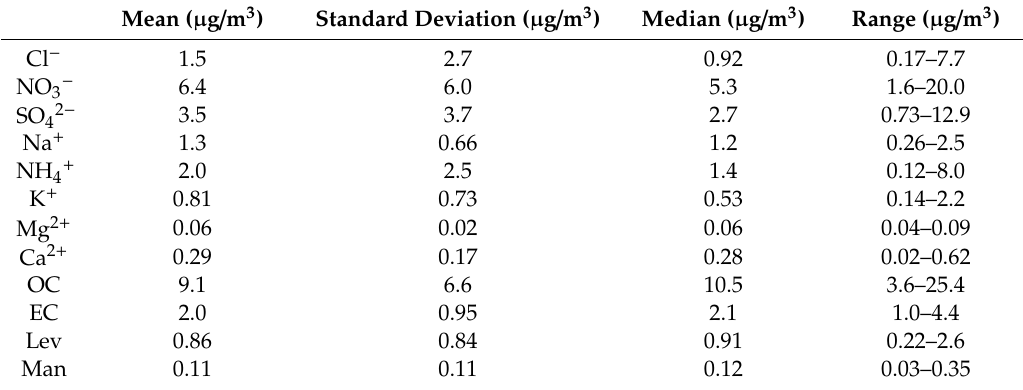
Table 2. Summary of ambient concentrations of major PM 2.5 constituents ( µ g / m 3 ) at the monitoring station located in Graz Don Bosco (DB), 2 January–31 March